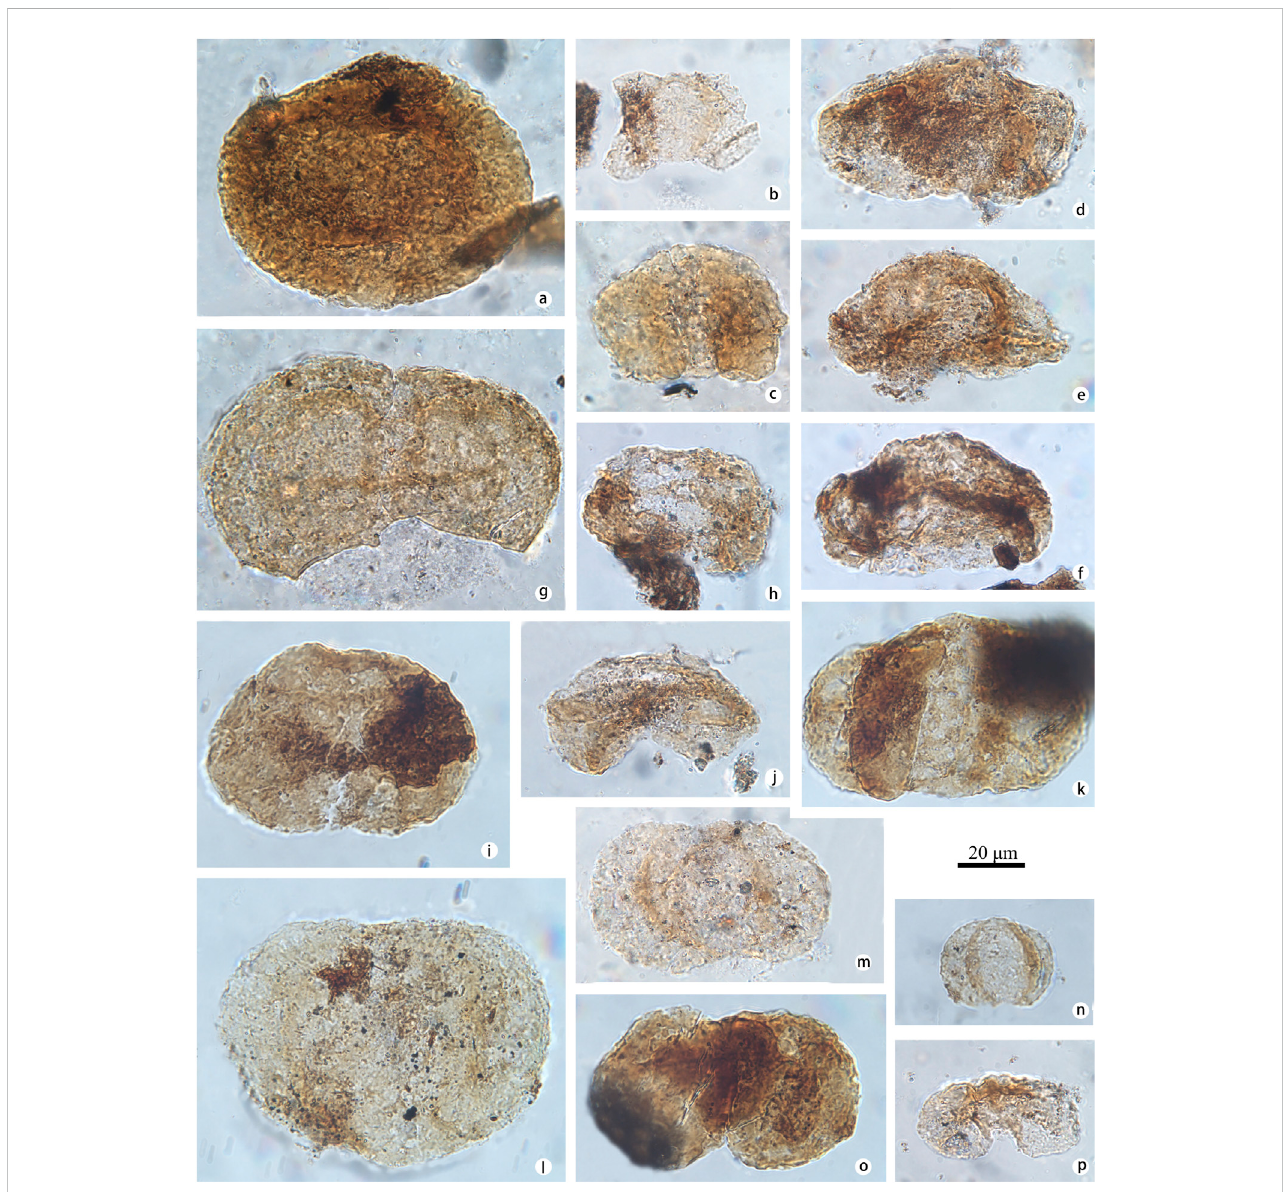
FIGURE 3 Selected pollen identi fi ed at the Yunmeng pro fi le (taxon name followed by sample number and position in England fi nder in parentheses). (A) Plicatipollenites indicus (Lele, 1964) (a-STYM01, J46-3); (B) Striatoabieites sp. 1 (b-STYM21, L47-4); (C) Striatoabieites brickii (Sedova, 1956) (c-STYM01, L19-3); (D – F) Striatoabieites duivenii (Jansonius) (Hart, 1964), (d-STYM21, N41-3; e-STYM16, S14-1; f-STYM28, S23-1); (G) Taeniaesporites combinatus (Qu and Wang, 1990) (g-STYM01, M18-4); (H) Taeniaesporites albertae (Jansonius, 1962) (h-STYM28, F39-1); (I) Taeniaesporites junior (Klaus, 1960) Wu, 1982 (i-STYM88, A42-1); (J) Taeniaesporites leptocorpus (Qu, 1984) (j-STYM21, L45-1); (K) Protohaploxypinus samoilovichii (Jansonius) (Hart, 1964) (k-STYM48,T13-3); (L) Protopinussubluteus Bolkh,1956(l-STYM21,O34-4); (M) Alisporitesnuthallensis (Clarke,1965)(m-STYM01,K28-4); (N) Alisporites parvus (De Jersey, 1962) (n-STYM82, E21-4); (O) Platysaccus luteus (Bolkh.) (Li and Shang, 1980) (o-STYM88, I41-3); (P) Platysaccus queenslundi (De Jersey, 1962) (p-STYM21,